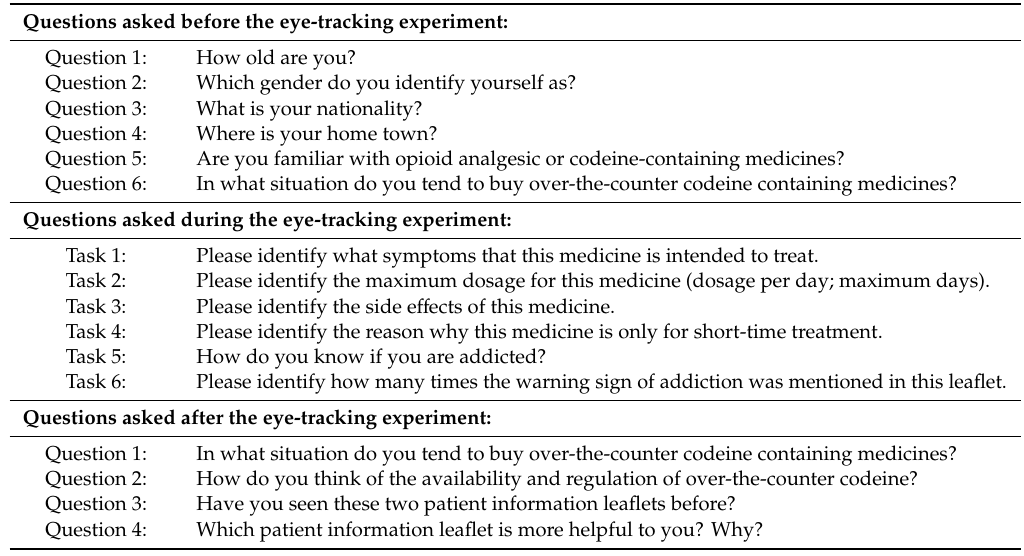
Table 1. Questions asked before, during, and after the eye-tracking